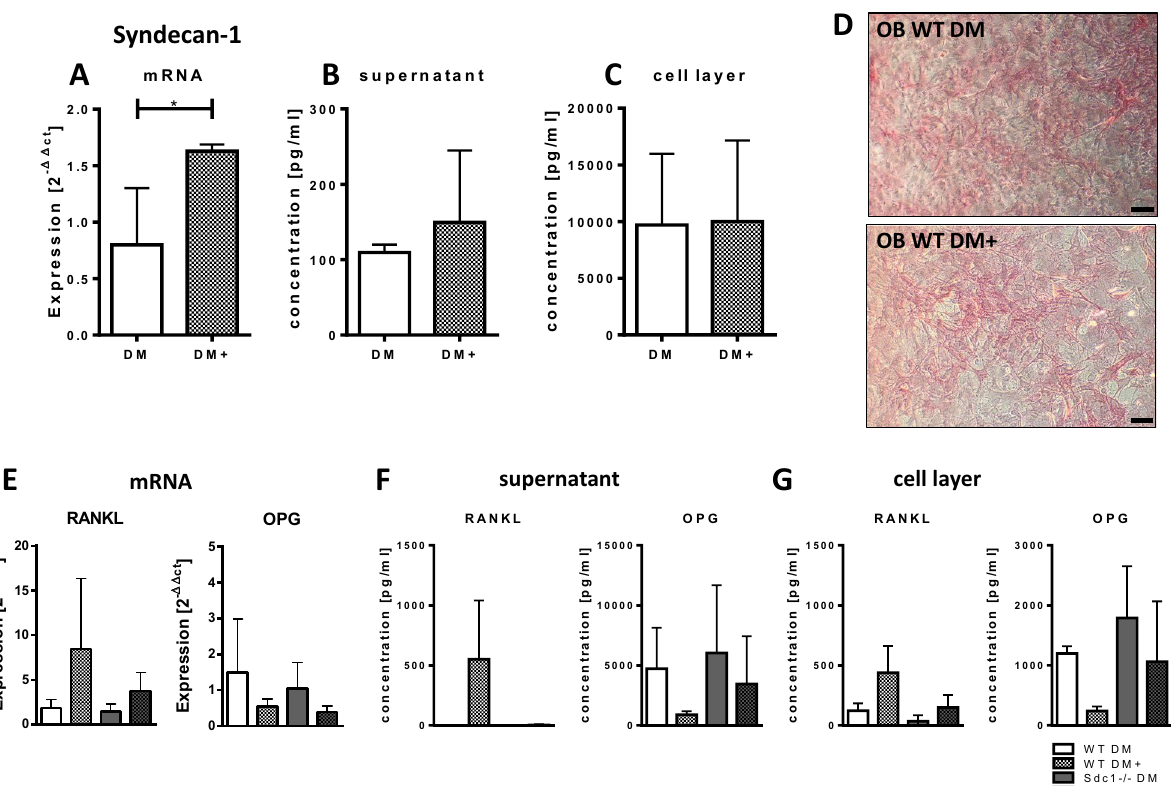
Figure 3. Syndecan-1, RANKL and OPG expression was analysed after stimulation of osteoblastic cells with DM or DM + medium (day 7). ( A ) mRNA expression of Syndecan-1 (in WT cells) was determined by real time PCR. ( B,C ) The concentration of soluble Syndecan-1 protein in the supernatant ( B ) and cell layer ( C ) of cells (WT) was analysed by ELISA. Experiments were performed in triplicates. Mann–Whitney- U test, * p < 0.05. ( D ) Protein expression of Syndecan-1 in the cells (WT, Sdc1−/−) was detected using a polyclonal antibody against Syndecan-1 (in red) on the cell layer of osteoblasts (OB). Scale bar: 50 µm, ( E ) mRNA expression of Tnfsf11 (RANKL) (left) or Tnfrsf11b (OPG) (right) in WT and Sdc1−/− osteoblastic cells was determined by real time PCR (Primers see Table 2) normalized to HPRT and day 0 (ΔΔCT method). ( F,G ) The concentration of RANKL and OPG protein in the supernatant ( F ) and cell layer ( G ) of cells (WT, Sdc1−/−) was analysed by ELISA. Experiments in ( E , F ) were performed in five independent replicates; Experiments in ( G ) were performed in